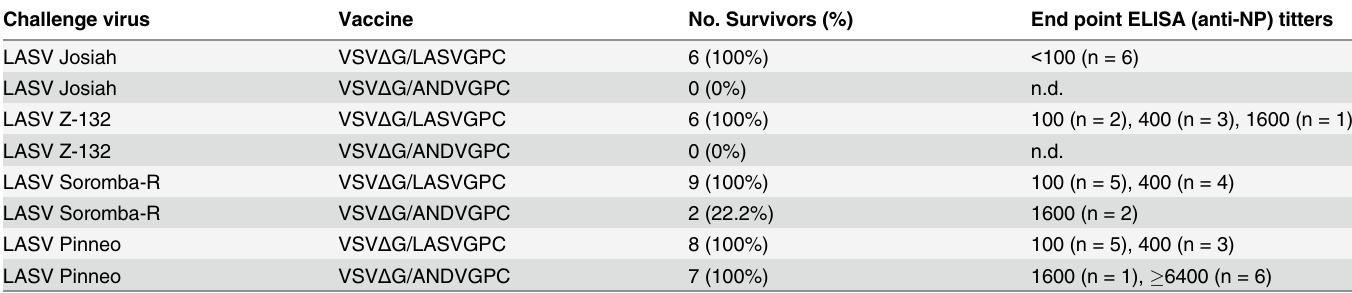
Table 1. End-point ELISA titers for the determination of seroconversion in immunized and control strain 13 guinea pigs post-Lassa virus challenge. Challenge